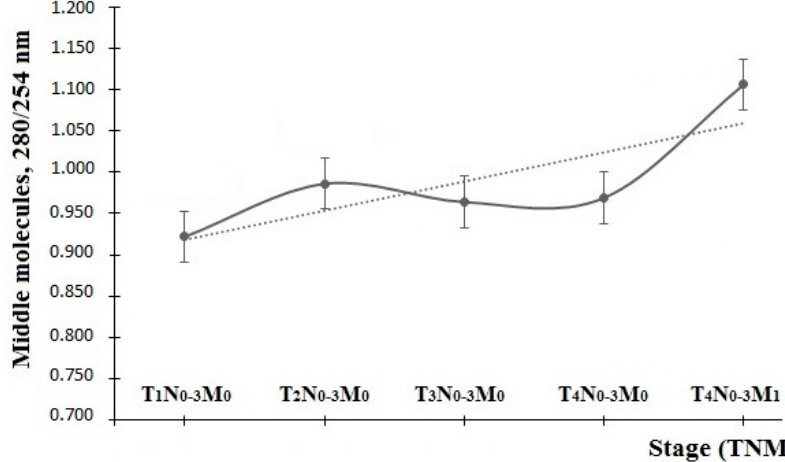
Figure 1. Dynamics of MM levels under normal conditions and in the context of cancer pathology.